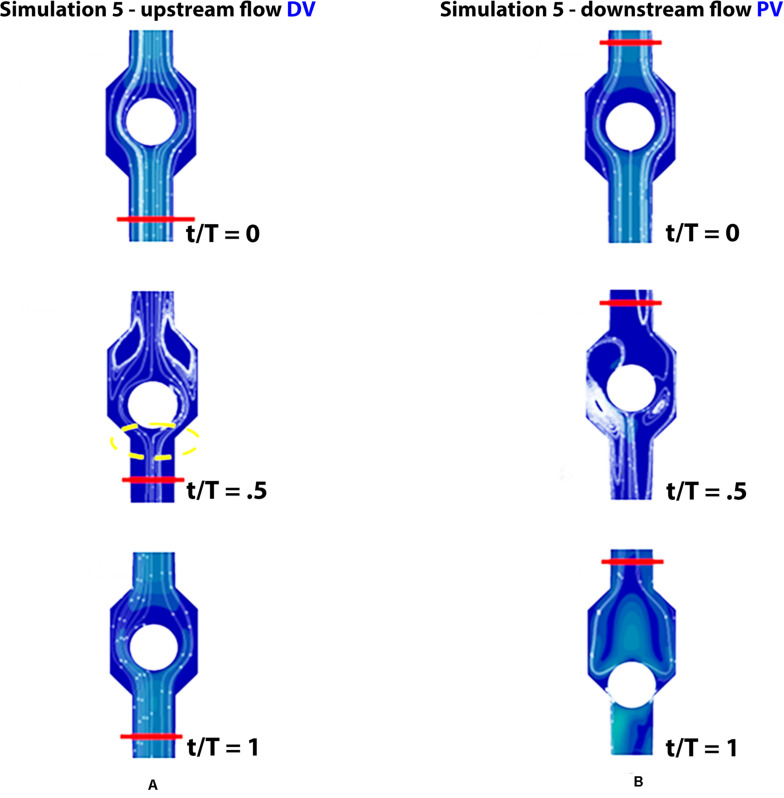
Valve positions during different phases of the walking cycle, lasting 1 s, in subjects with partial dysfunction (simulation 5). Upstream of the distal valve (A) and downstream of the proximal valve (B), incompetent space of the upstream valve is marked by yellow dashed lines.